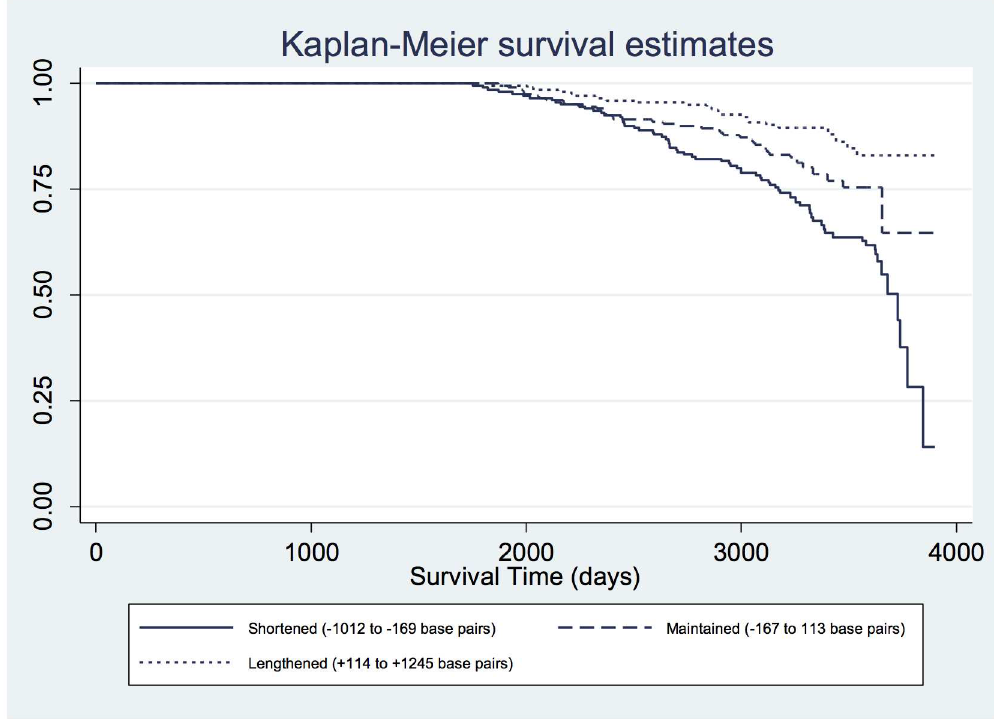
Fig 2. Survival in 608 patients with coronary heart disease, stratified by change in telomere length during the previous 5 years (overall log rank test p < 0.0001).